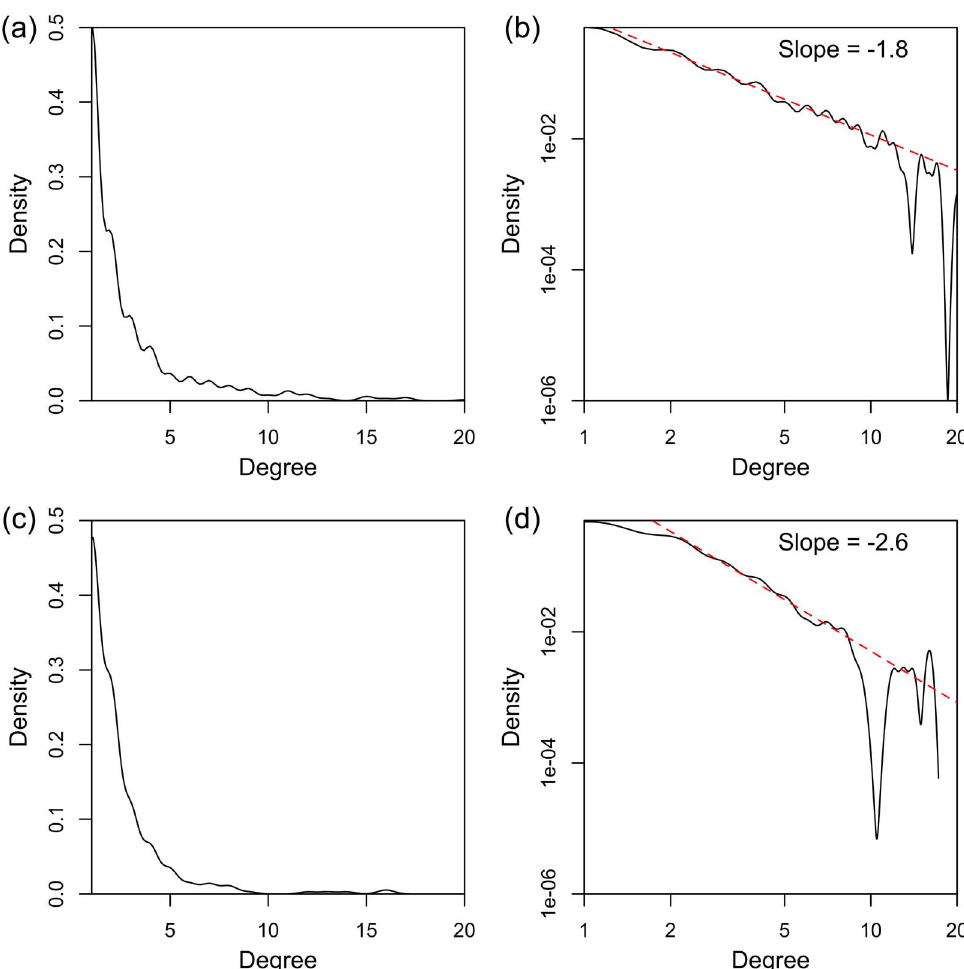
Figure 5. Larger significant subnetworks: degree distributions. Degree distributions (kernel-smoothed) on linear and log scales, for (a), (b) KIRC large subnetwork, and (c), (d) LUAD large subnetwork. Dashed red lines on the log-log plots display the power-law linear model line of best fit, estimated from the nodes with degree in the range 2 to 8, with the corresponding slope value (i.e., power law exponential coefficient) displayed